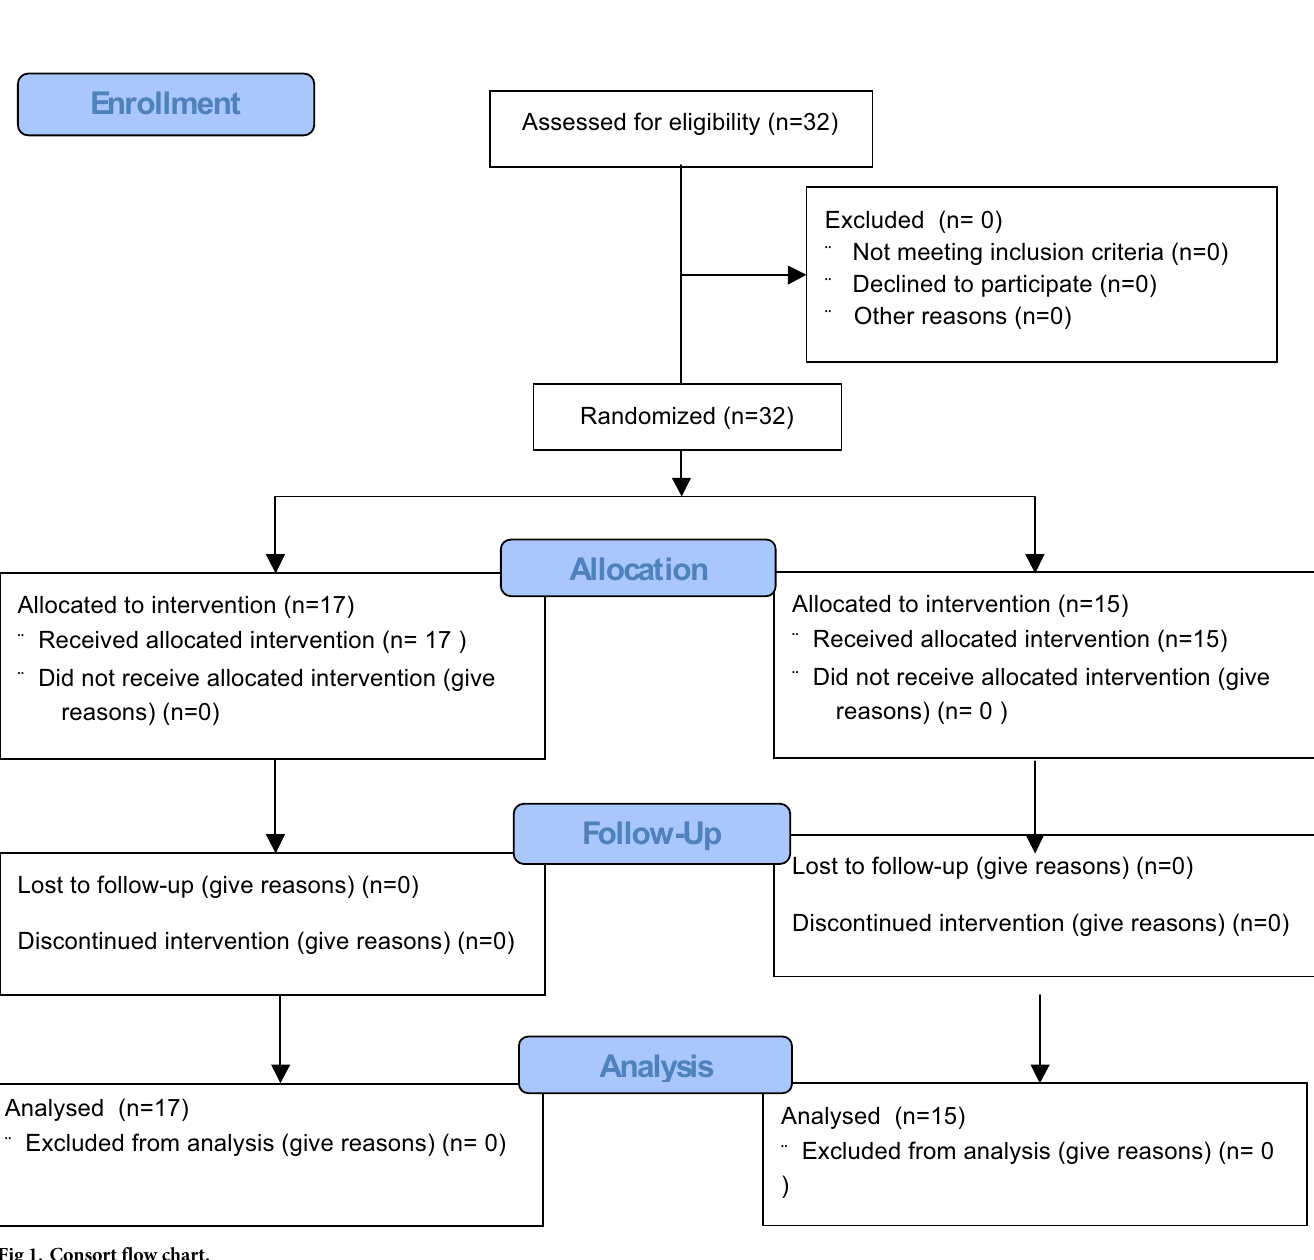
Fig 1. Consort flow